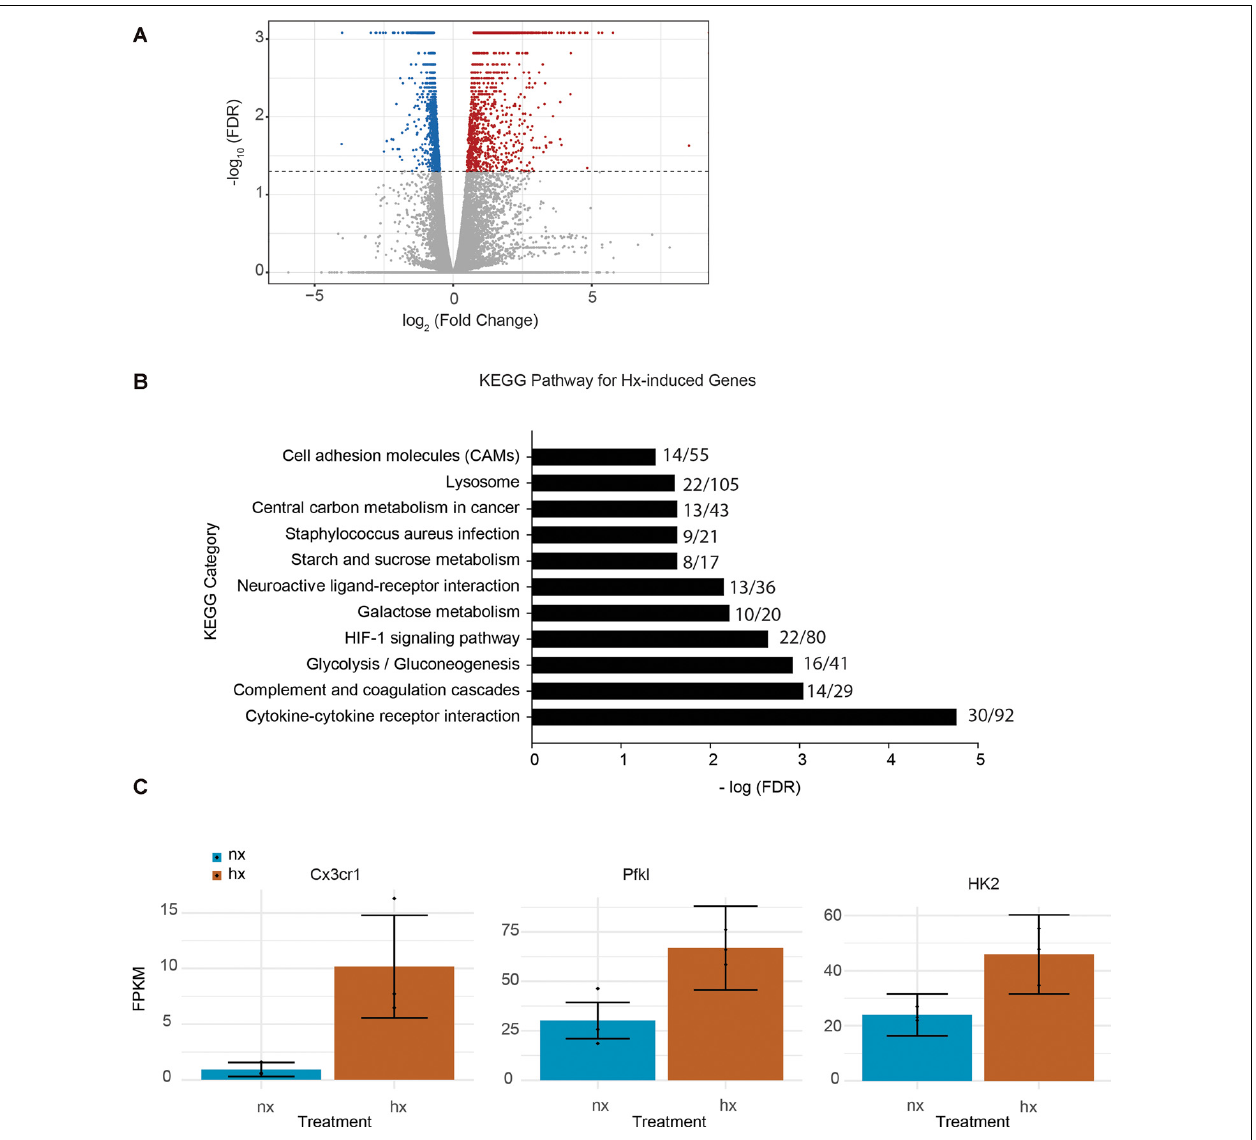
FIGURE 1 | Hypoxia changes microglial gene expression and upregulates metabolic- and cytokine receptor-related genes. (A) Volcano plot of microglial differential gene expression after Hx exposure. Red dots are upregulated genes, blue dots are downregulated genes. (B) Upregulated genes were analyzed for KEGG pathway enrichment using STRING software. The numbers at the end of each bar represent the observed/expected genes in each category. (C) FPKMs of genes upregulated by Hx that are in the categories of “cytokine-cytokine receptor interaction” or “HIF-1 signaling.” Results are derived from n = 3 biological